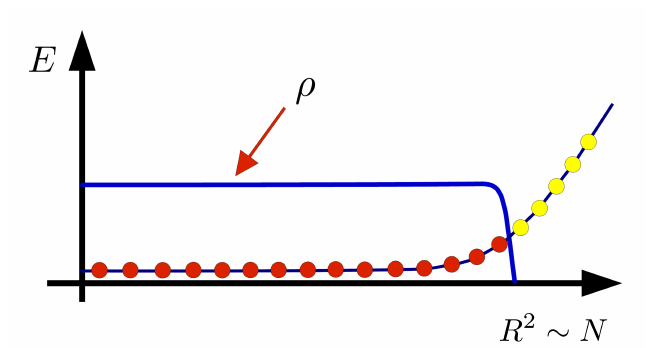
Figure 5: Energy levels of the first filled Landau level as a function of angular momentum m ∝ r 2 (red filled, yellow empty levels). Near the edge, m ∼ N , r 2 = R 2 ∼ N , the confining potential breaks the degeneracy leading to a kind of Fermi surface in coordinate space. The radial shape of the density ρ ( r 2 ) is also